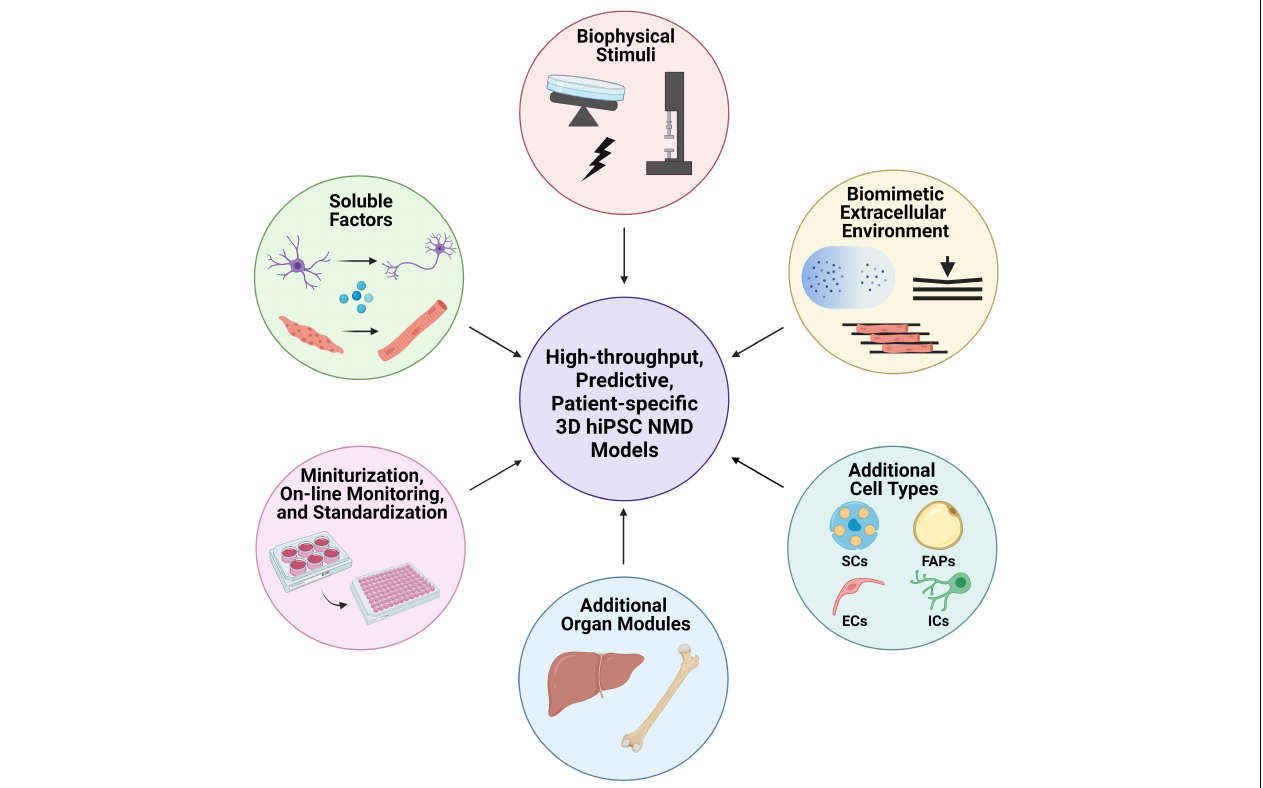
FIGURE 6 | Future developments of hiPSC-derived NMD models. Optimization of soluble factor treatments will be needed to improve maturity of MNs, SkM, and NMJs toward their respective in vivo -mimetic phenotypes. Incorporation of biophysical stimulation during cell culture such as electrical stimulation, mechanical stretch, and media agitation are expected to further improve functional maturity of NMJs. Biomaterial design and microfabrication/microfluidics techniques can be applied to generate biomimetic microenvironments for cell growth via controlled presentation of developmentally relevant gradients in growth factors, topography, and stiffness. As the function of native NMJs relies on complex multi-cellular interactions, the ability to incorporate Schwann cells (SCs), endothelial cells (ECs), fibro-adipogenic progenitors (FAPs), and immune system cells (ICs) would improve modeling of in vivo states and our understanding of NMJ physiology and pathology. Incorporation of additional organ compartments sharing culture media with NMJs, such as intestine, gut, and liver will better emulate human drug responses, while adding bone, ligament, cartilage, and fat compartments will allow studies of the organ-organ crosstalk in NMDs. Finally, further miniaturization and standardization of culture systems along with development of non-invasive metabolic and functional readouts will enable establishment of versatile NMD platforms for high-throughput drug discovery